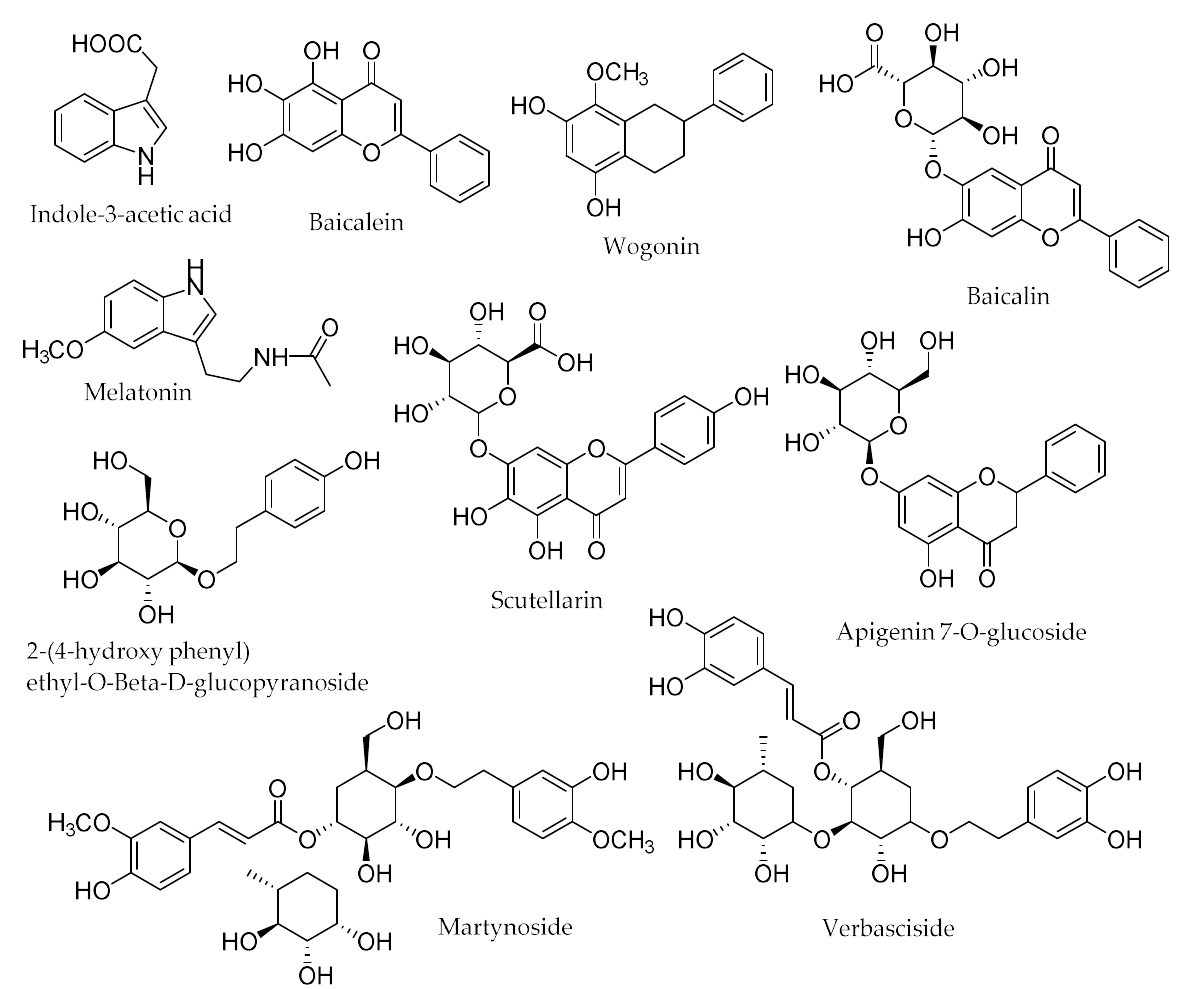
Figure 2. Dominant compounds isolated from Scutellaria species.